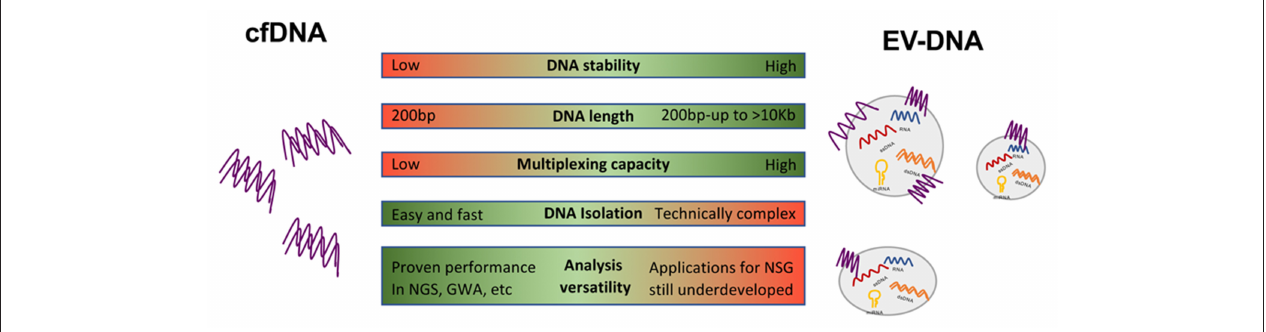
FIGURE 1 | Advantages and disadvantages of EV-associated DNA and cfDNA. Circulating cell-free (cfDNA) shows a half-life of 2h. However, extracellular vesicles (EVs) and associated content are stable for longer times. EVs display a wide range of DNA fragment sizes compared to highly fragmented cfDNA. Multiple EV cargo allows for polyvalent multiplexed analysis. DNA isolation is easy and fast for cfDNA but is technically more complex and time-consuming in the case of EVs. Non-targeted sequence-based analyses in EV-DNA are still underdeveloped while cfDNA has proven remarkable performance in next-generation sequencing techniques (NSG) and studies based in gene-wide analysis